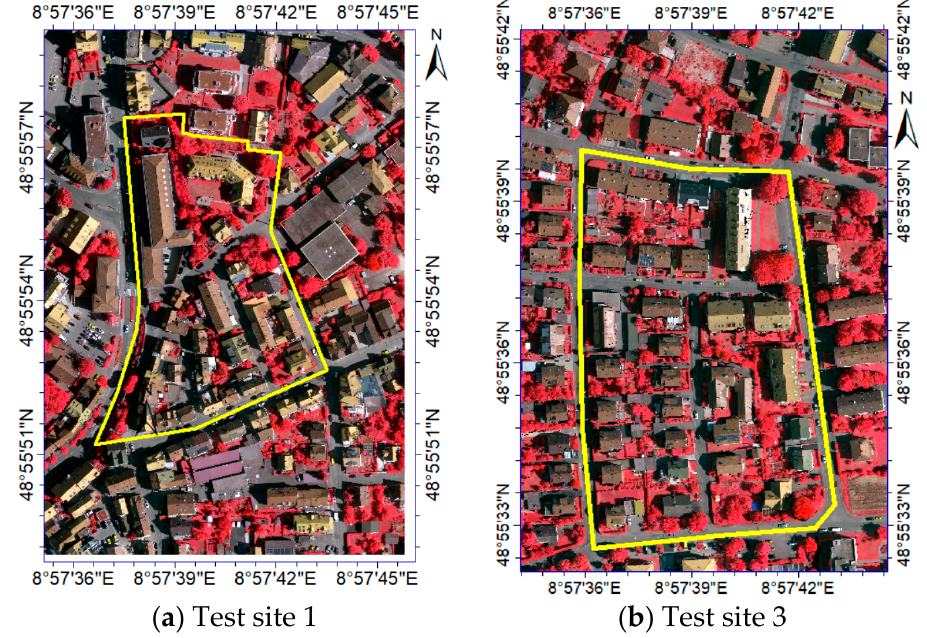
Figure 2. Two test sites in the Vaihigen dataset: ( a , b ) are test site 1 and test site 3,